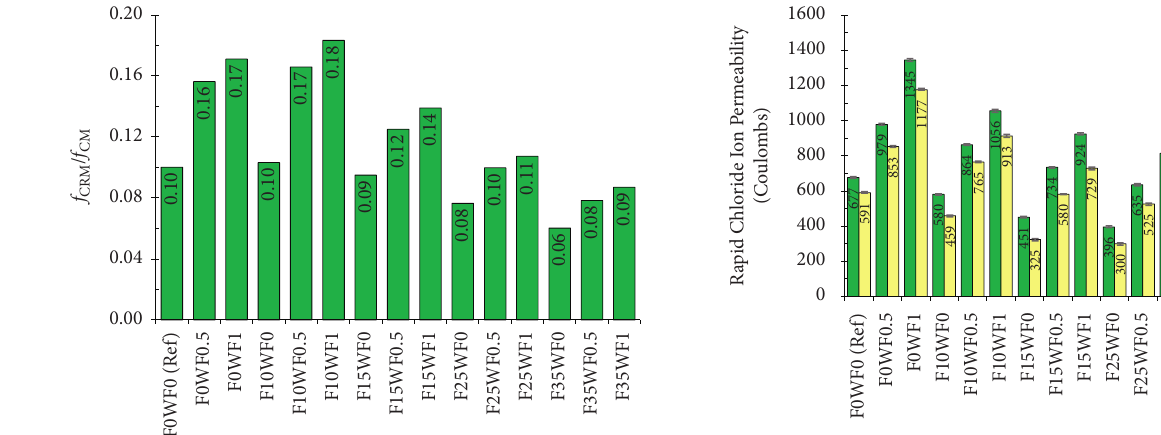
Figure 15: The ratio between f CRM and f CM of all HSC mixes. Figure 17: RCP of each HSC mix with different incorporation levels of FA and WSF.